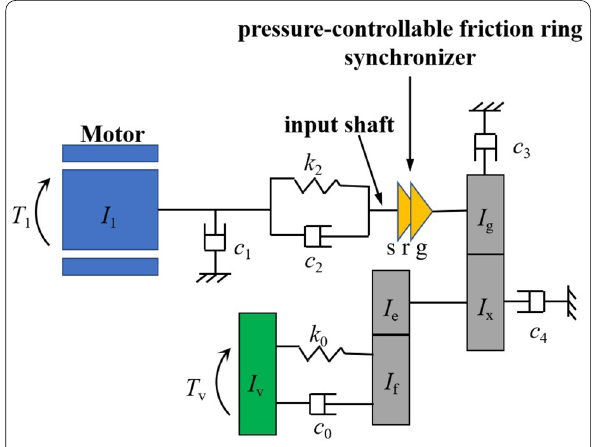
Figure 11 The transmission system with PCFRS